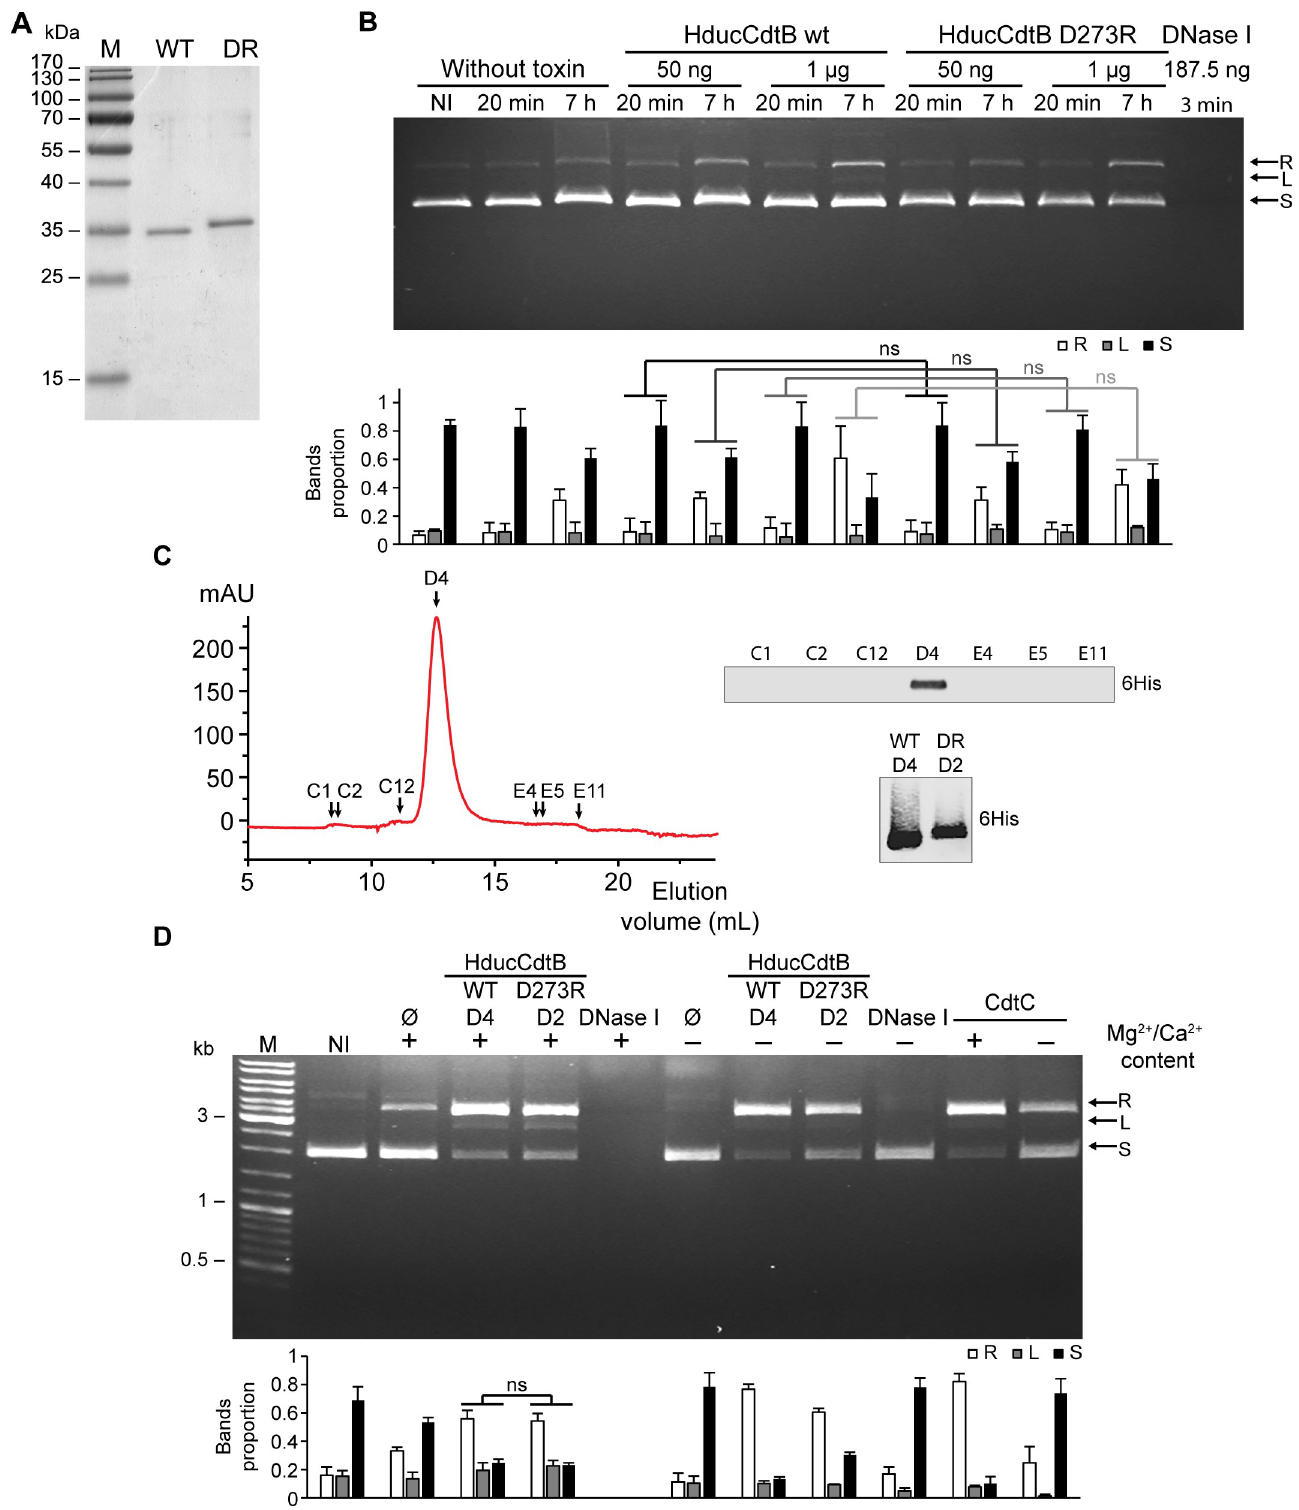
Fig 3. Wild-type or mutant HducCdtB proteins purified under denaturing conditions present a similar plasmid digestion activity. A. SDS-PAGE analysis of WT and D273R (DR) HducCdtB proteins purified from E . coli NiCo21 (DE3) under denaturing conditions. B. Kinetics and CdtB concentration effect on plasmid digestion assay with WT or D273R HducCdtB. Agarose gel electrophoresis and quantification of supercoiled plasmid (250 ng) incubated in presence of the